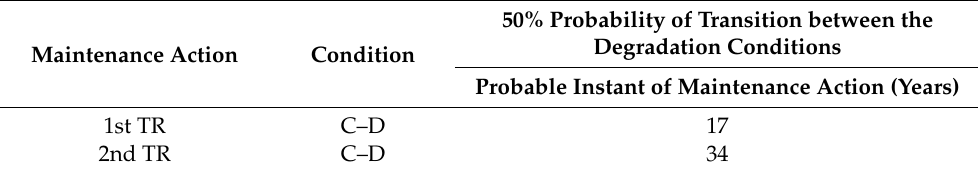
Table 3. Instants for the total replacement of ETICS considering the first maintenance strategy (MS1), considering a time horizon of 40 years.